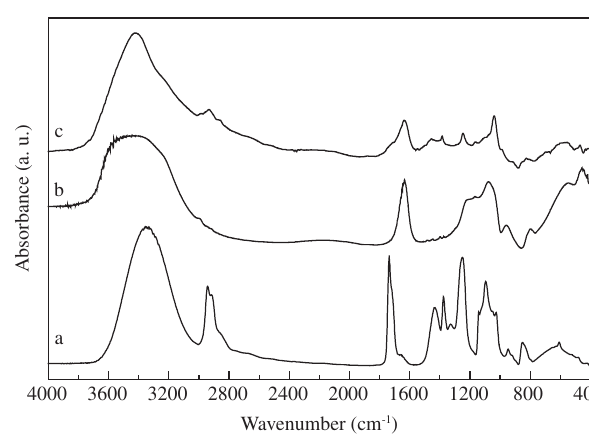
Figure 1. Schematic drawing of the Inorganic-Organic hybrid synthesized based on PVA polymer and bioactive glasses; a) PVA chain with variable hydrolysis degree; b) hybrid network structure.